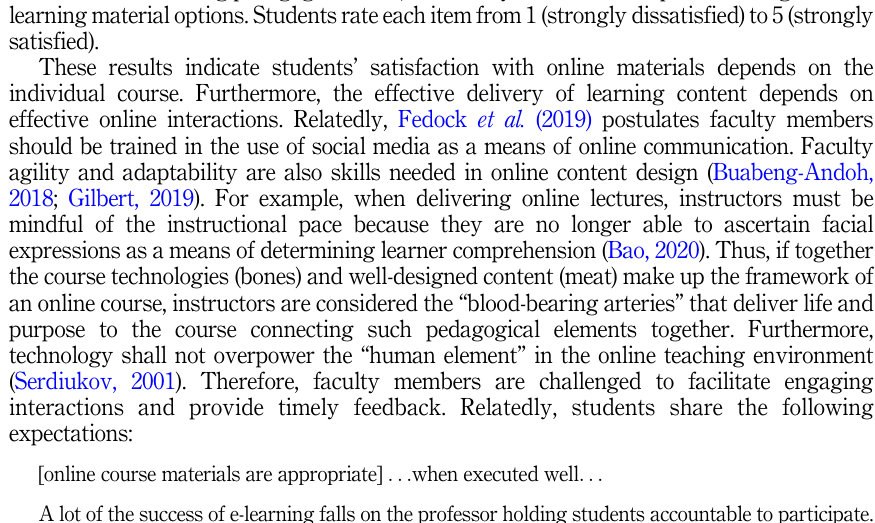
(1) Videos of instructors using learning glass technology; (2) Animated PowerPoint with instructor narratives, and (3) Zoom synchronous class recordings. Surprisingly,